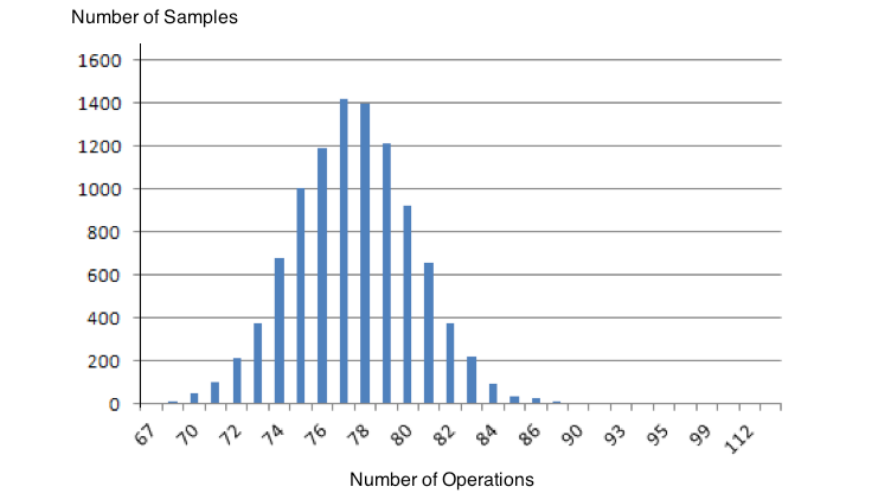
Figure 2. Distribution at the output of zChaff running problems with n = 50 and m = 50 , m = 1 . n